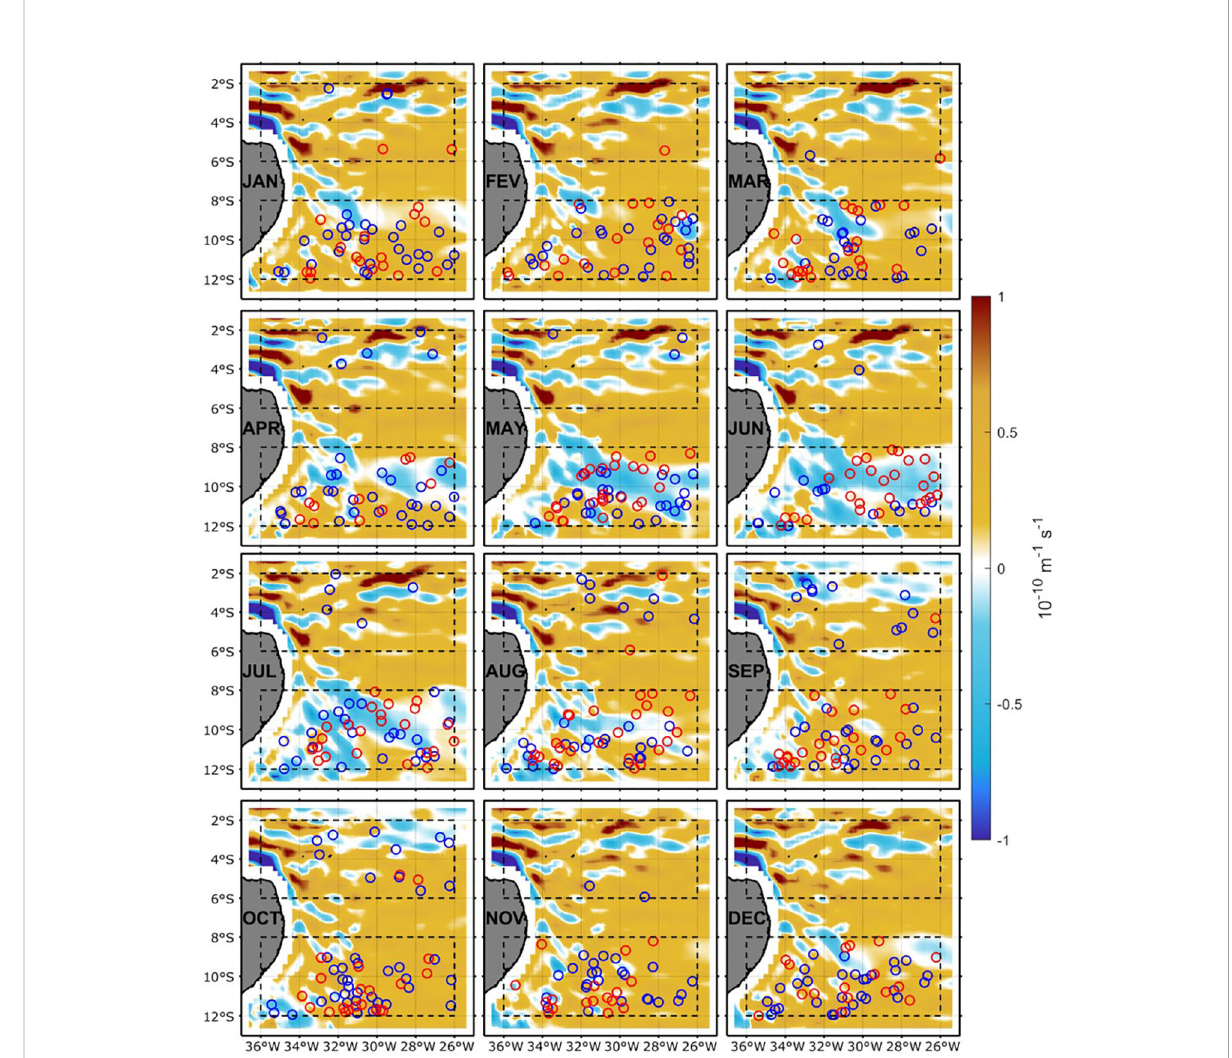
FIGURE 8 1993 – 2018 monthly mean maps of gradient of absolute vorticity of large-scale currents (color shading) superimposed with eddy location of long-lived eddies generated off northeast Brazil between 1993 and 2018 (blue and red circles for cyclonic and anticyclonic eddies